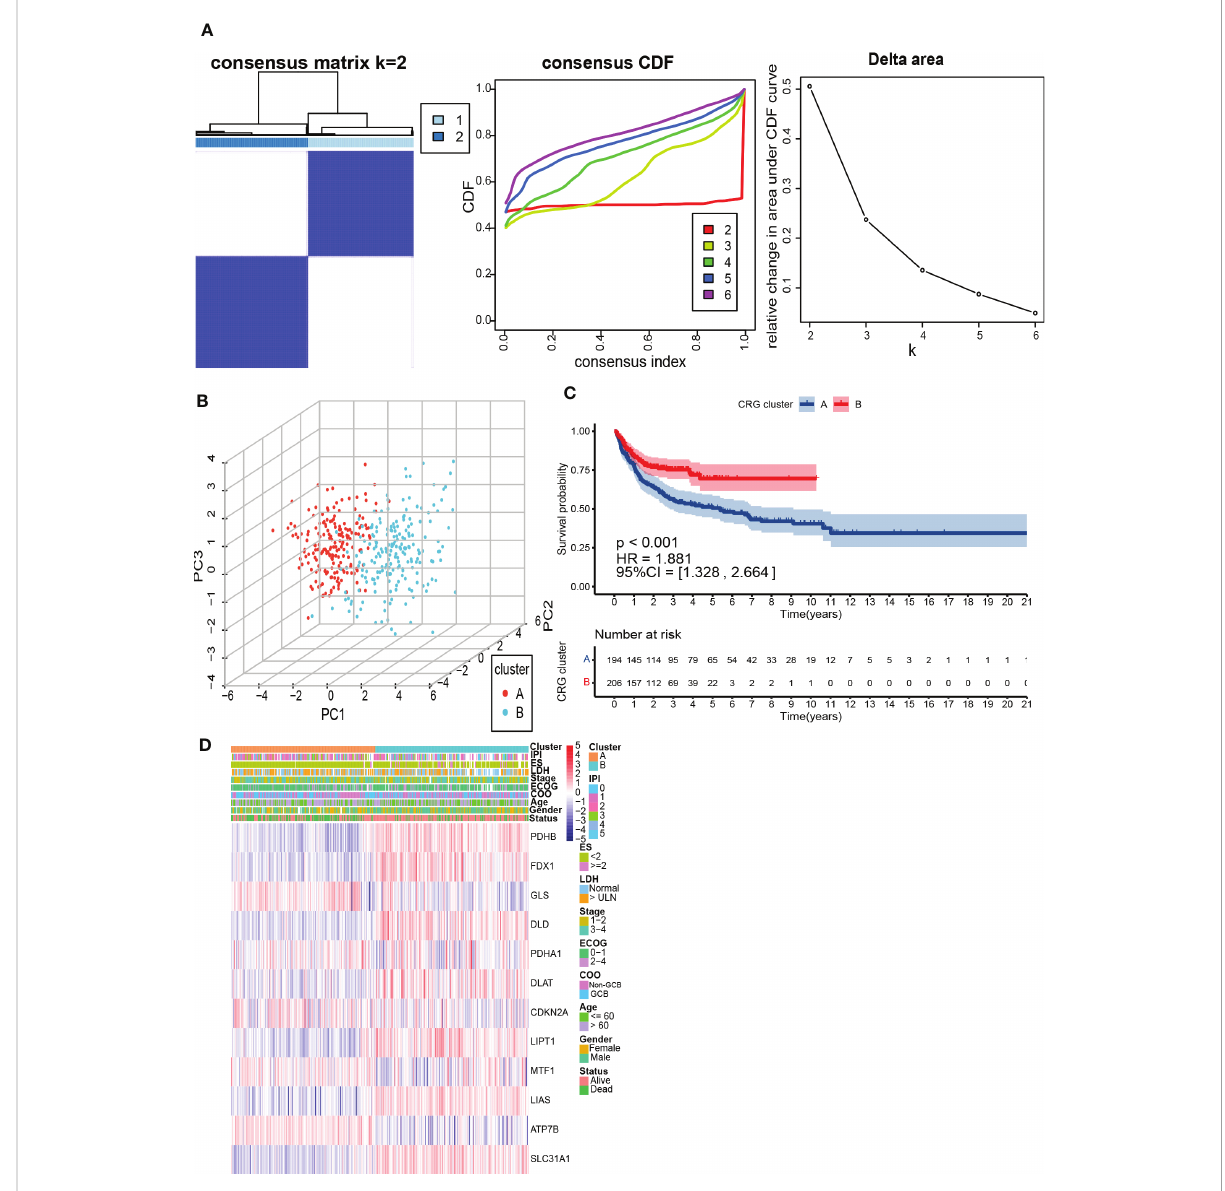
FIGURE 2 Identi fi cation and assessment of the CRG subtypes. (A) The consensus matrix, consensus cumulative distribution function (CDF), and delta area by cluster analysis based on CRGs. Two clusters (k=2) would be best. (B) Principal component analysis of two CRG clusters. (C) Kaplan-Meier survival curves of two CRG clusters (p < 0.001). (D) Heatmap of clinical features and CRGs expressions between subtypes. LDH, lactate dehydrogenases; ES, extranodal sites; ECOG, The Eastern Cooperative Oncology Group performance score; COO, cell of origin; IPI, International Prognostic